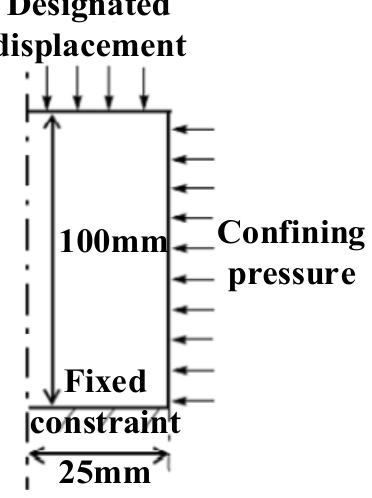
Figure 7. Boundary conditions of the model. Table 1. Model coal material parameters.